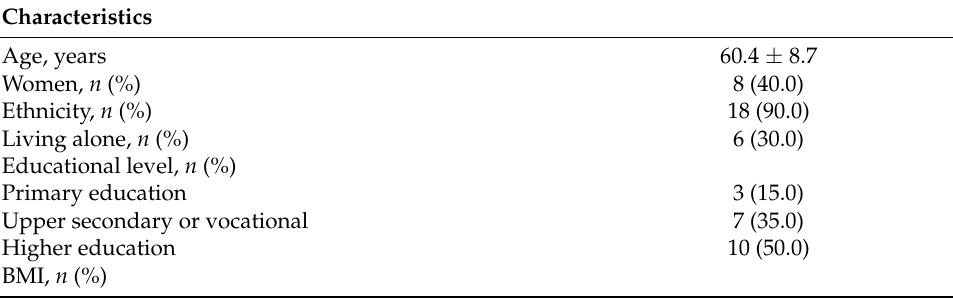
Table 2. Baseline characteristics of